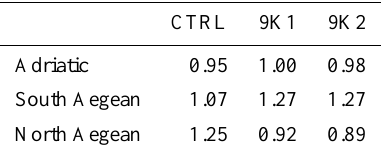
Table 2. Index of Stratification (IS, in m 2 s − 2